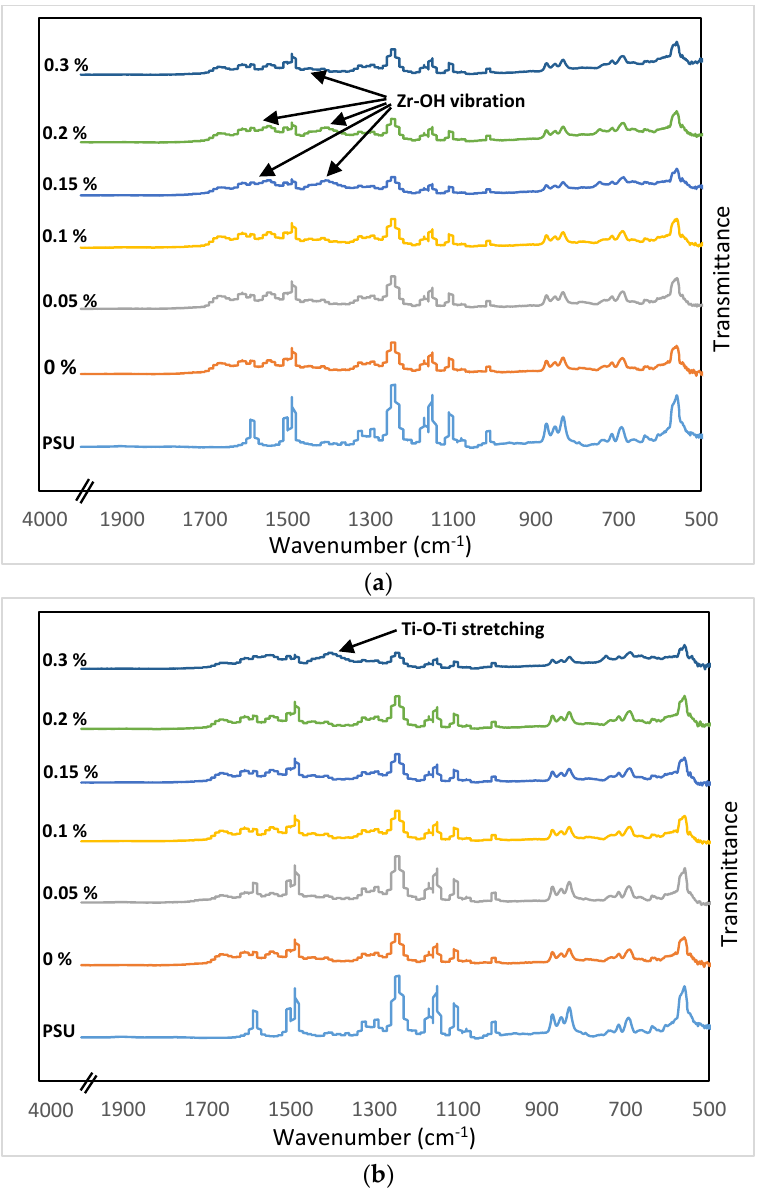
Figure 3. Attenuated total reflection Fourier transform infrared (ATR FT-IR) spectra for ( a ) UiO-66 and ( b ) MIL-125.